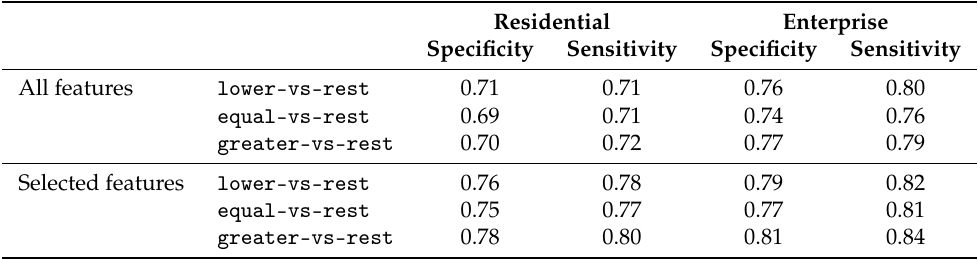
Table 2. Average results obtained by repeatedly training MLPs on the datasets that stored information about hourly electrical loads, for both residential end enterprise